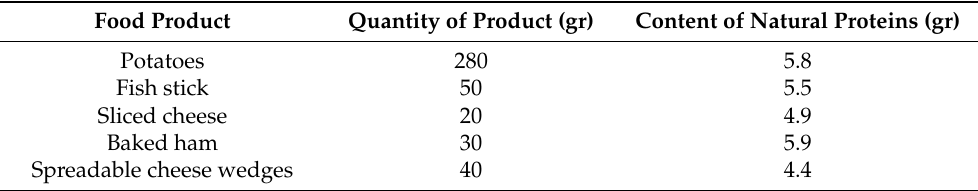
Table 2. List of the dietary products and quantities (in grams) equivalent to 250 mg Phe.